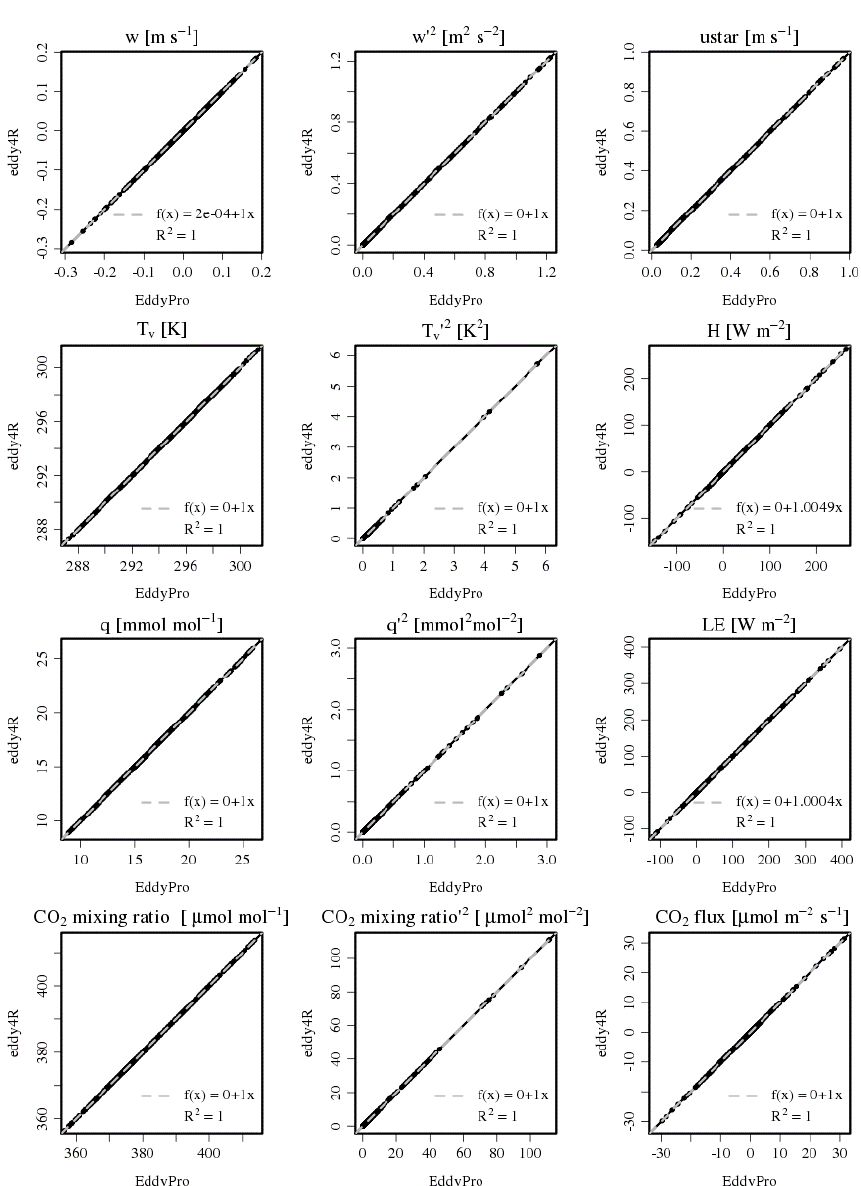
Figure 13. Scatterplot of means (vertical wind speed, w ; sonic temperature, T v ; H 2 O dry mole fraction, q ; and CO 2 dry mole fraction), variances and fluxes (friction velocity, ustar; sensible heat flux, H ; latent heat, LE; CO 2 flux). Data are generated from July to August 2011 US-PFa data in EddyPro and eddy4R. Each point represents a 1h averaging period. Black lines are 1:1 lines, and dashed lines are robust regressions (Salibian-Barrera and Yohai,